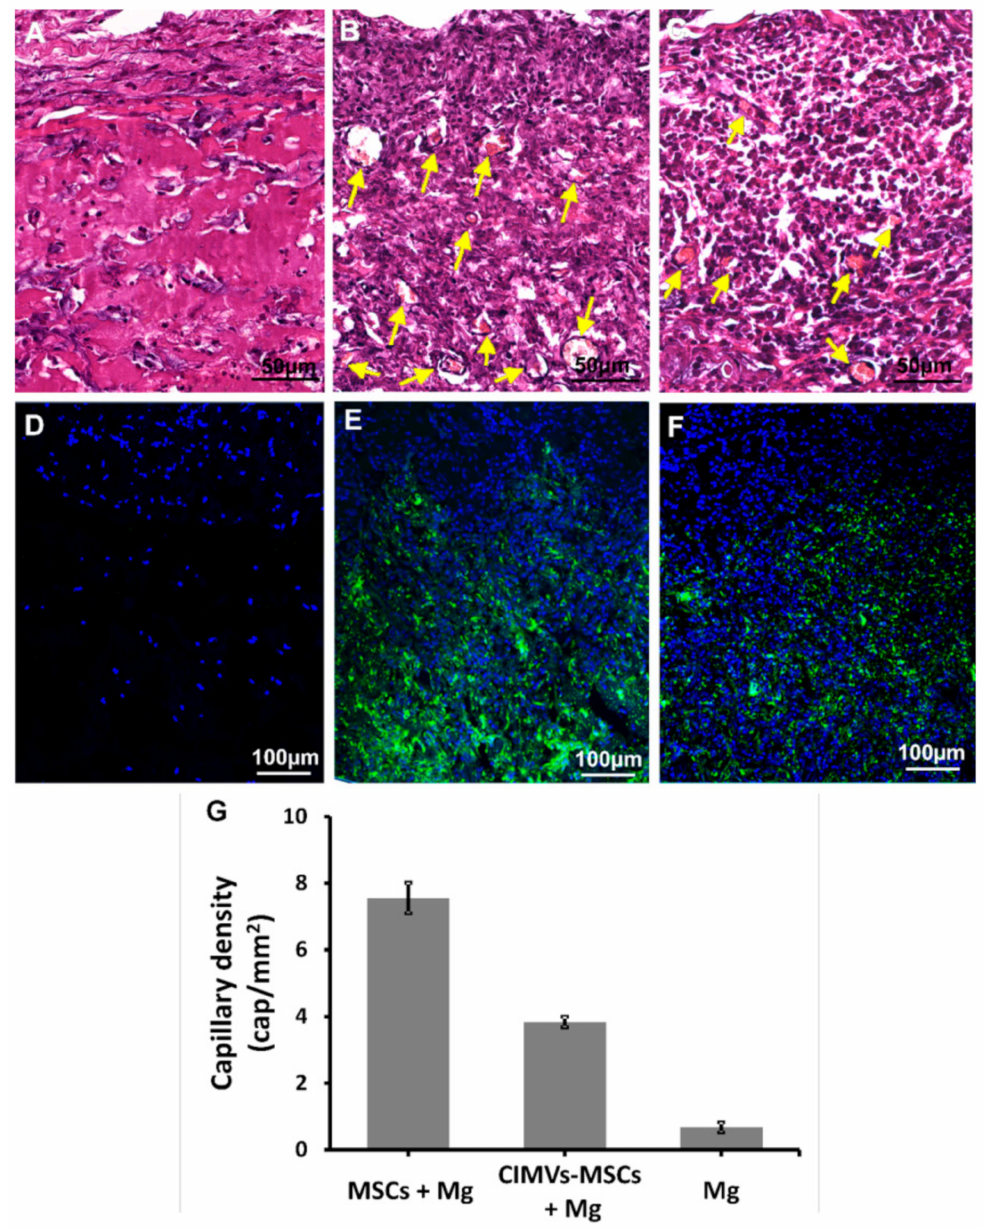
Figure 6. Analysis of angiogenic activity of MSCs and CIMVs-MSCs in vivo. Hematoxylin / eosin staining ( A–C ) and fluorescence micrographs ( D–F ) are shown after subcutaneous injections in rats (6 animals per experimental group) of MSCs (10 6 cells) or CIMVs-MSCs (50 µ g). ( A and D ) Negative control (subcutaneous injection of Matrigel matrix); ( B and E ) subcutaneously injection of MSCs; ( C and F ) subcutaneous injection of CIMVs-MSCs. MSCs and CIMVs-MSCs were stained with DiO (membrane dye) before the subcutaneous injection. Green fluorescence—DiO stained MSCs and CIMVs-MSCs; blue fluorescence—DAPI (stains DNA). Arrows mark the position of the sprouting blood capillaries. Counting of the total number of vessels was carried out using the AxioVision 4.8 program (CarlZeiss, Oberkochen, Germany). ( G ) Quantitation of the capillary density in Matrigel matrix plugs. The data represents mean ± SD. For statistical analysis, ten hematoxylin and eosin stained slides per animal were